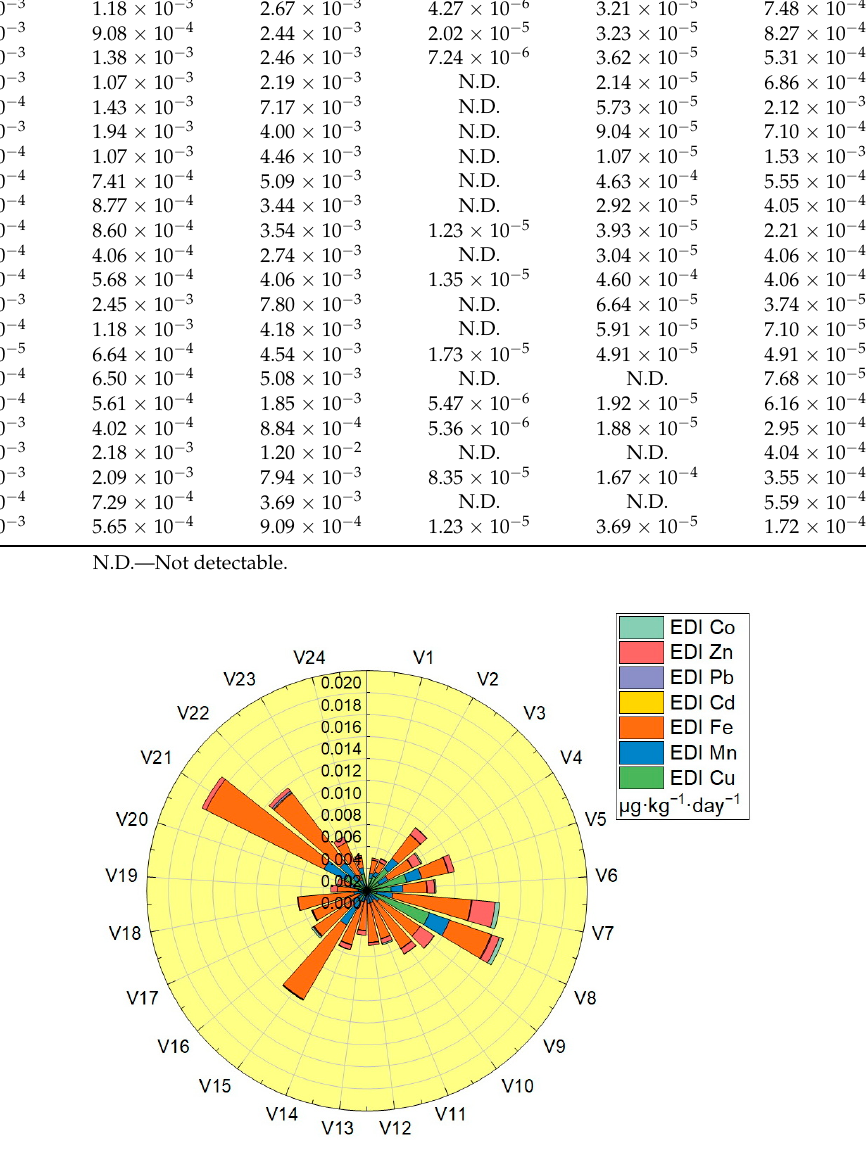
Figure 7. Graphical representation of the estimated daily intake (EDI).